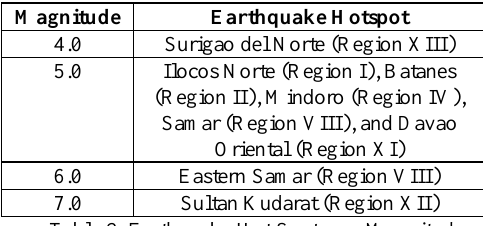
Table 2. Earthquake Hot Spots per Magnitude Most of these provinces are in the southern region and the hot spots lie near or along the major trenches found in the